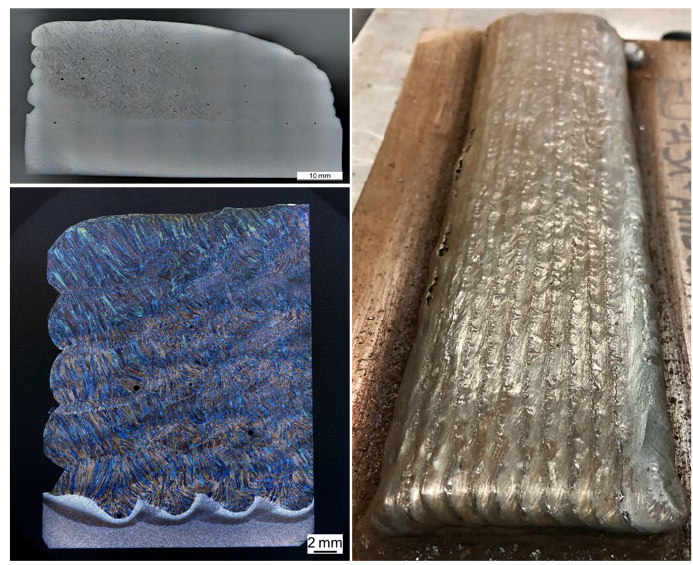
Figure 7. Welded composite.